Question: Looking at the figure, what chart type is it?
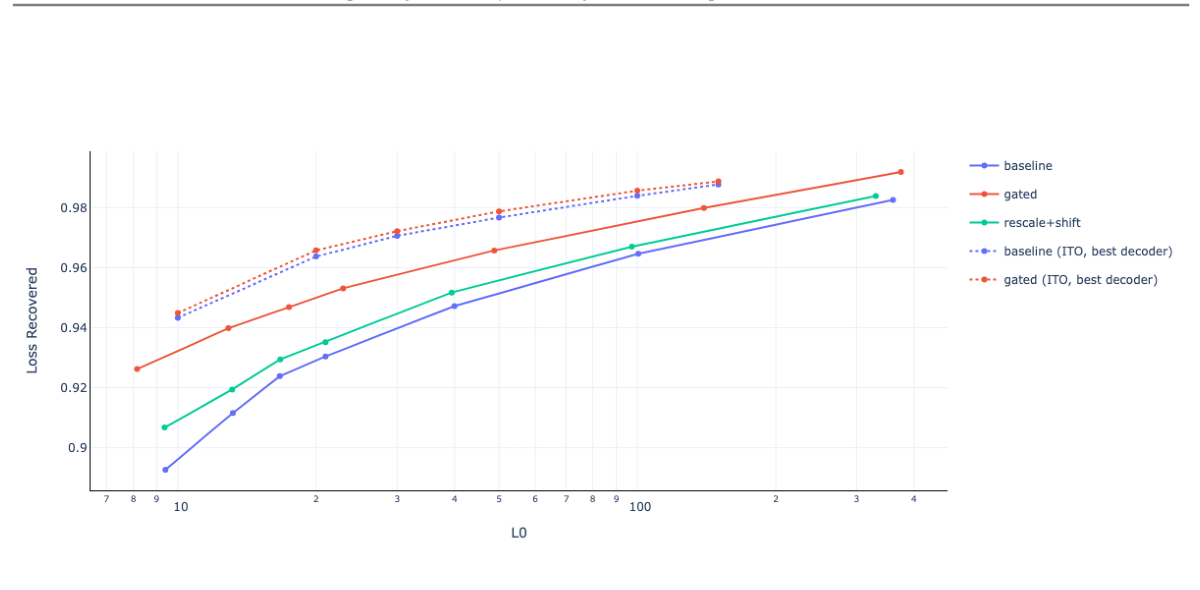
Answer: line